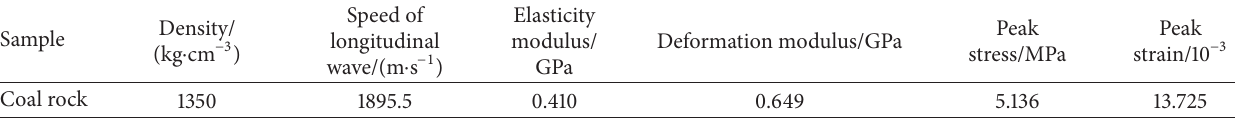
Table 1: Some physical and mechanical properties of coal rock under static load.